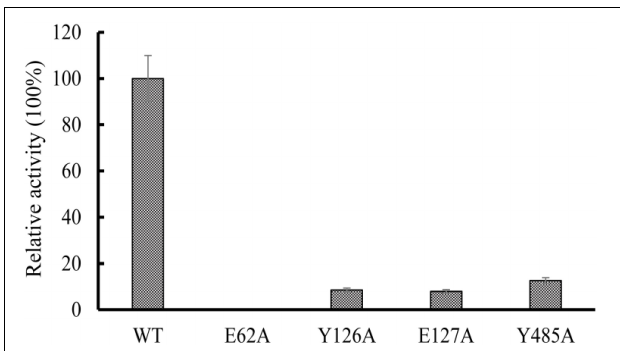
FIGURE 6 | Relative activity of wild-type OXC from M. mageritense (OXCmm), E62A, Y126A, E127A, and Y485A. All assays were repeated three times. The error bars indicate the standard deviation of the independent